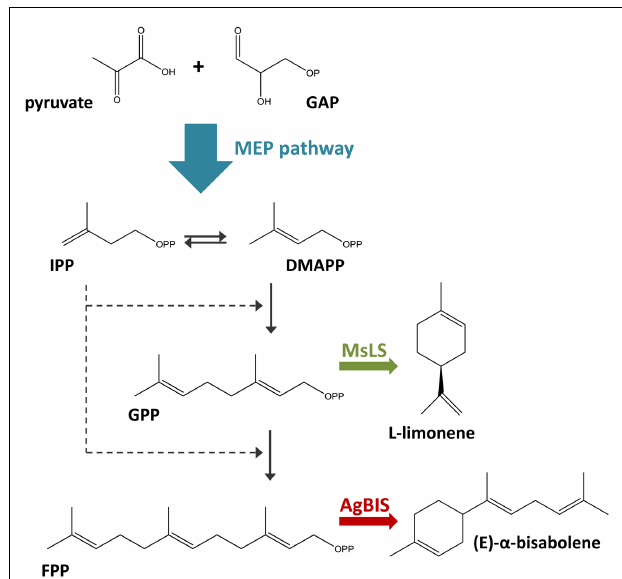
FIGURE 1 |Terpenoid biosynthesis via the 2-C-methyl- D -erythritol 4-phosphate (MEP) pathway .The MEP terpenoid biosynthetic pathway converts pyruvate and glyceraldehyde-3-phosphate (GAP) feedstock to the C5 isomers, isopentenyl pyrophosphate (IPP), and dimethylallyl pyrophosphate (DMAPP).The stepwise addition of IPP to DMAPP generates C10 geranyl pyrophosphate (GPP) and C15 farnesyl pyrophosphate (FPP), the respective precursors to monoterpenes and sesquiterpenes. In this study, the heterologous expression of the M. spicata L -limonene synthase (MsLS) and A. grandis (E)- α -bisabolene synthase (AgBIS) in Synechococcus sp. PCC 7002 was designed to draw on GPP and FPP pools, respectively, generated by the native cyanobacterial MEP pathway for the production of the non-native terpenoids L -limonene and α